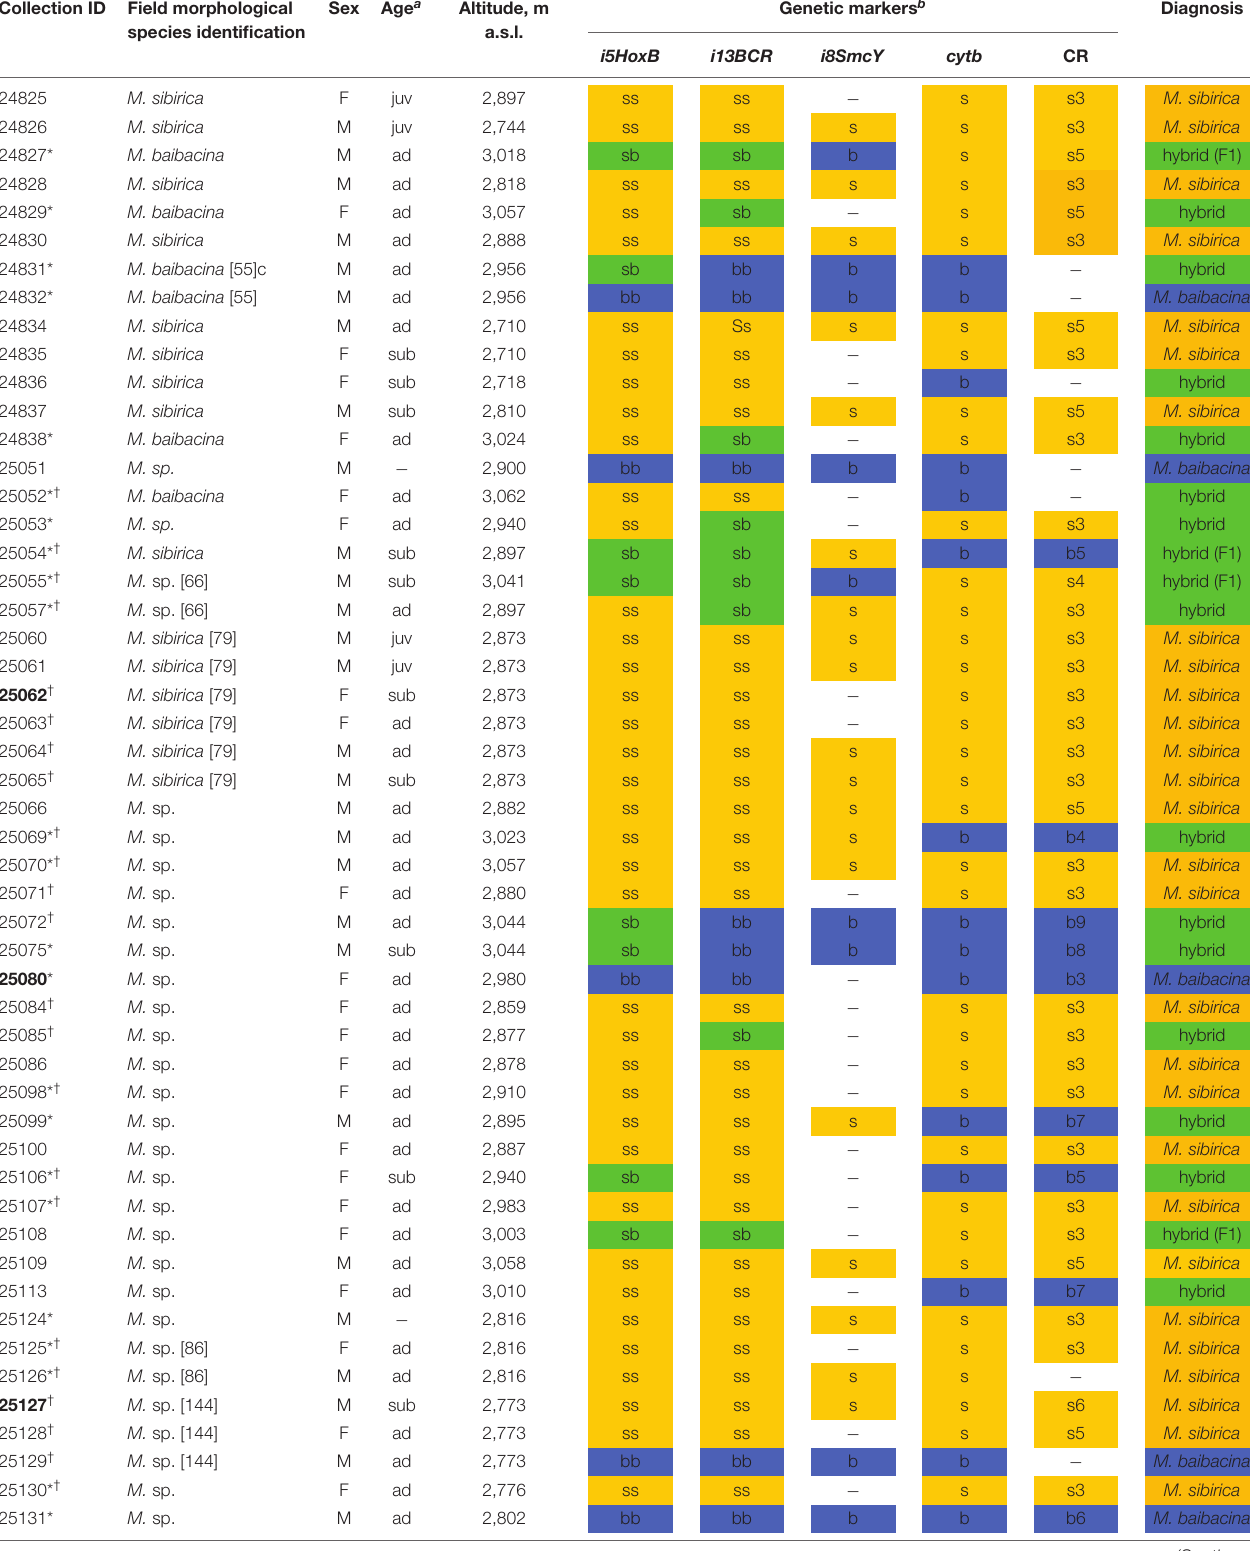
TABLE 1 | Characteristics and results of genotyping of marmots from mixed population of the Ulagchin-Gol valley. Collection ID Field morphological Sex Age a Altitude, m species identification